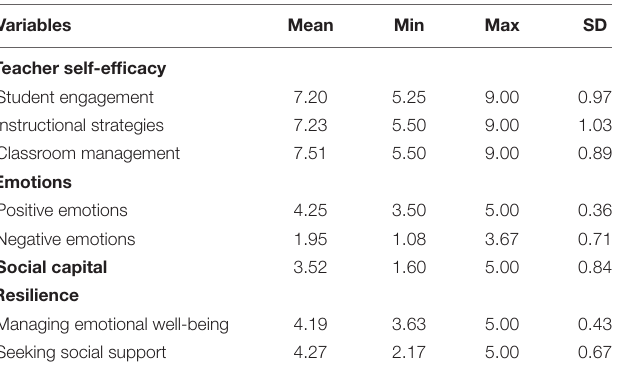
TABLE 2 | Descriptive statistics of quantitative measures.